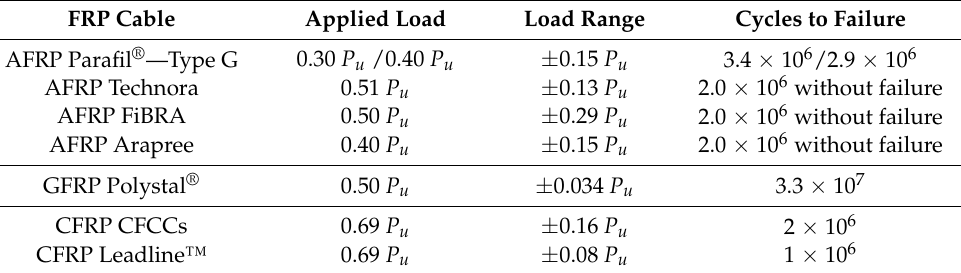
Table 5. FRP composite tendons: fatigue